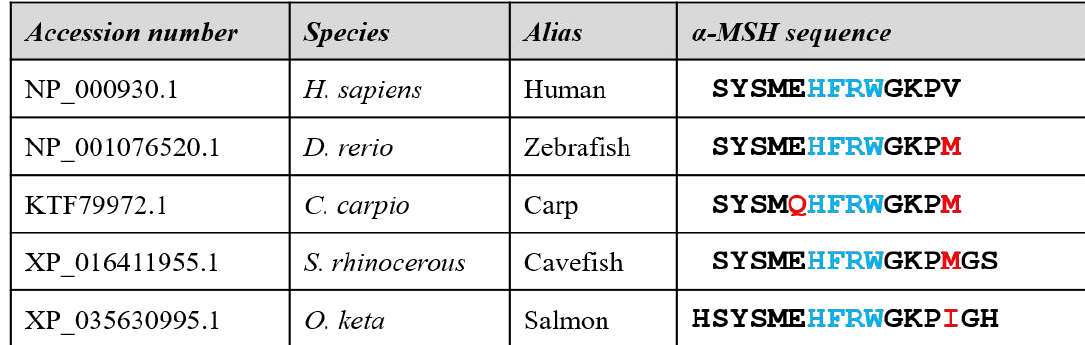
Figure 2. Sequence analysis and alignment of naturally-occurring α -MSH variants. ( a ) Clustal Omega alignment of four α -MSH variants in different species with human sequence as reference (dotted red box). Percentage Identity color scheme. The region demarcated by green bars indicates the 13-amino-acid α -MSH peptide. ( b ) Table listing the accession number of each α -MSH form used in the melanophore assay, including aliases for each species. The α -MSH sequences indicate the sequence of generated peptides; red letters indicate amino acid variations within the α -MSH peptide, while blue represents the HFRW